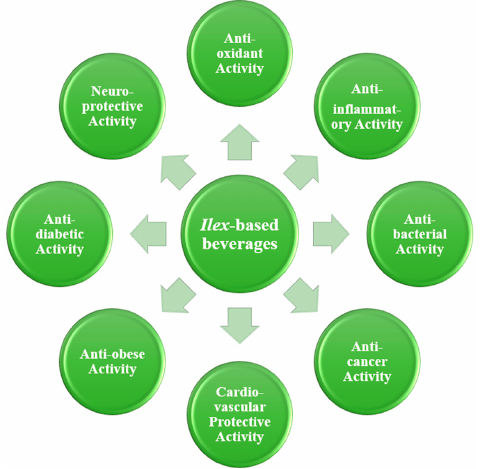
Figure 3. The health benefits of caffeinated beverages from the genus Ilex .